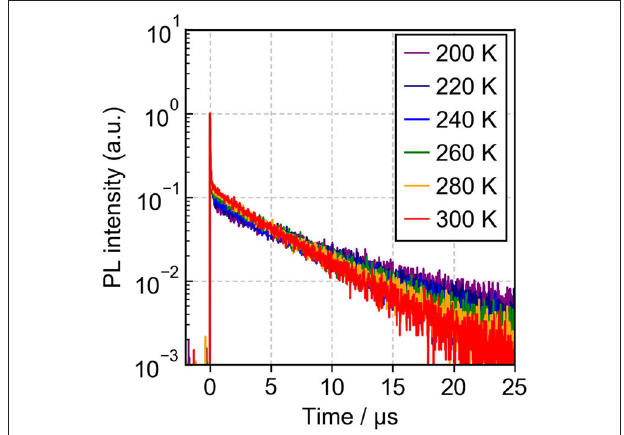
FIGURE 6 | PL decay curves of the 9 vol% TpIBT-tFFO:CzSi film observed at 470nm from 200 to 300K.